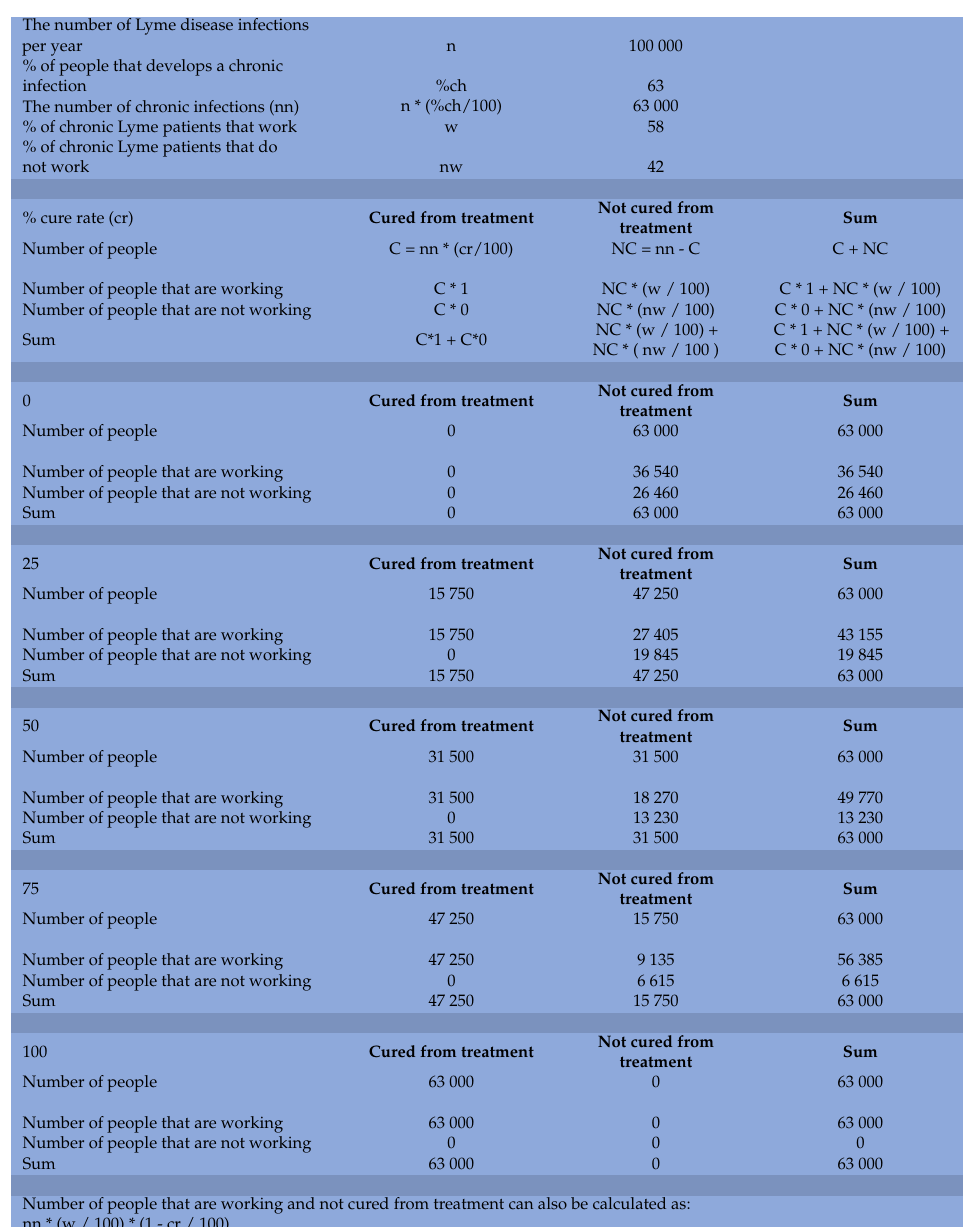
Table 15. The work/not work/cured/not cured